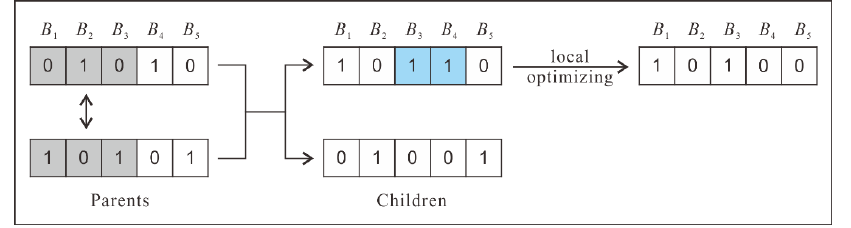
Figure 9. Example of uniform crossover considering conflicting